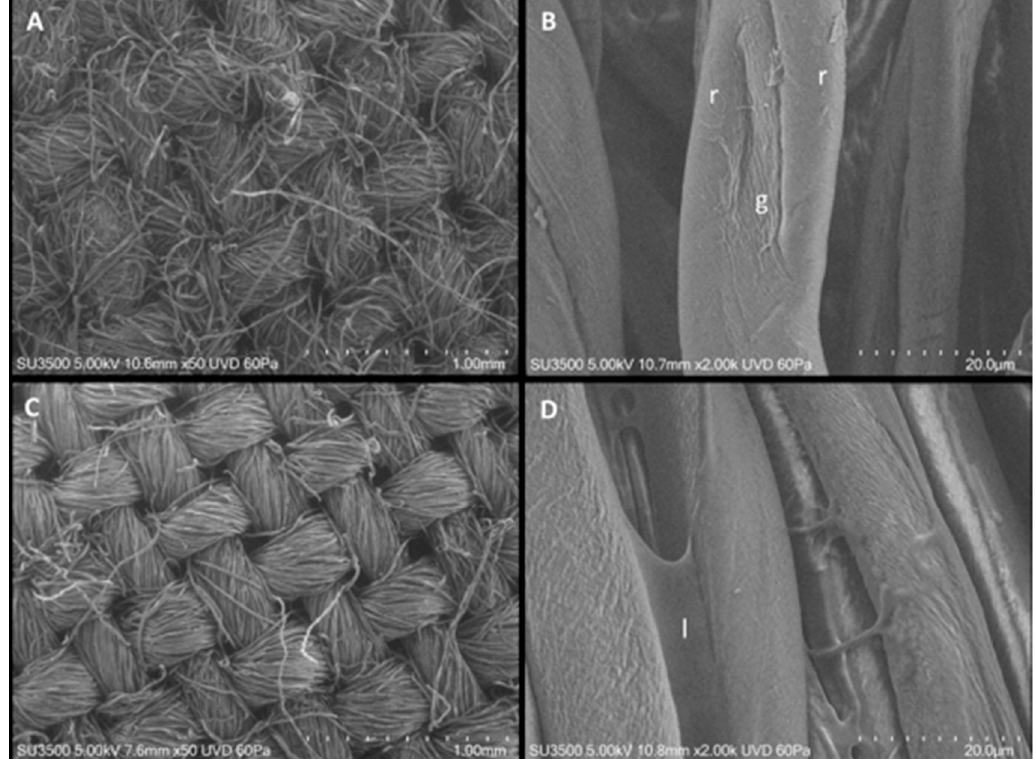
Figure 3. VP-SEM characterization of textiles without coating ( A , B ) and with coating ( C , D ). Textile without coating is imaged at 50×, scale bar 1 mm ( A ). The texture of the weaving is visible. It is formed by bundles of fibers arranged in a messy way ( B ). Textile single fiber is imaged at 2000×, scale bar 20 μ m, it appears similar to a ribbon, longitudinally grooved by a gutter (g), which is limited at the sides by bulging ridges (r). Fiber surface appears wrinkled in some parts, exfoliated in others. ( C ) GO-coated textile is imaged at 50×, scale bar 1 mm. The texture of the weaving is visible, fiber bundles appear as having a more compact and ordered aspect. ( D ) Coated textile fibers are imaged at 2000×, scale bar 20 μ m. (l).